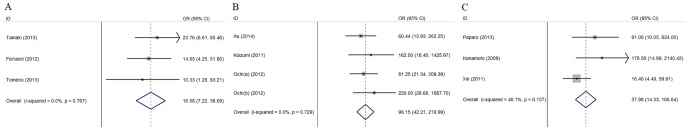
Forest plot from meta-analysis of DOR value using a random-effect or fixed-effect model for significant fibrosis.(A) Forest plot of LFI and (B) Forest plot of ER1 and (C) Forest plot of ER2. DOR: diagnostic odds ratio; LFI: liver fibrosis index; ER1: the elastic ratio of the liver for the intrahepatic vein; ER2: the elastic ratio of the liver for the intercostal muscle; Ochi (a): the training set of the subjects in the study by Ochi et al; Ochi (b): the validating set of the subjects in the study by Ochi et al.